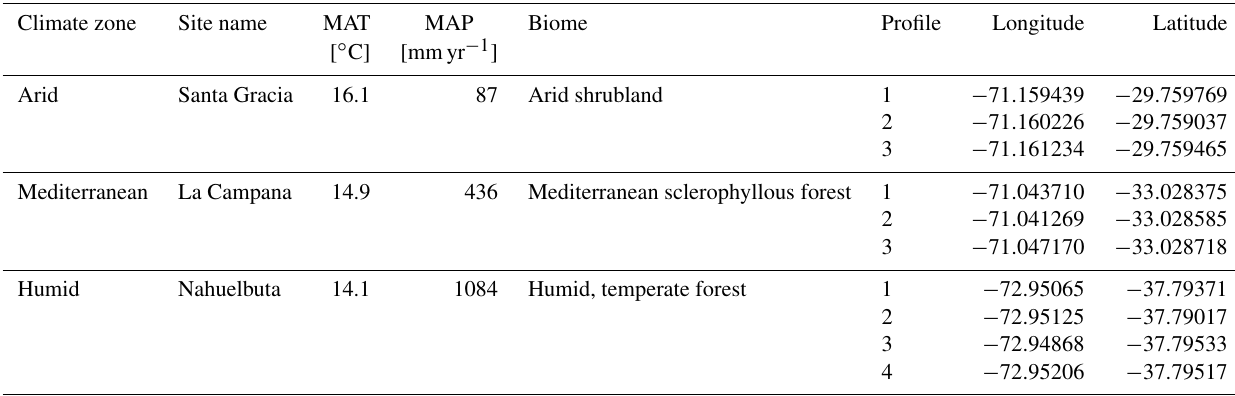
Table 1. Properties of the three sites in the Coastal Cordillera in Chile, including mean annual temperature (MAT), mean annual precipitation (MAP), and the locations of the soil